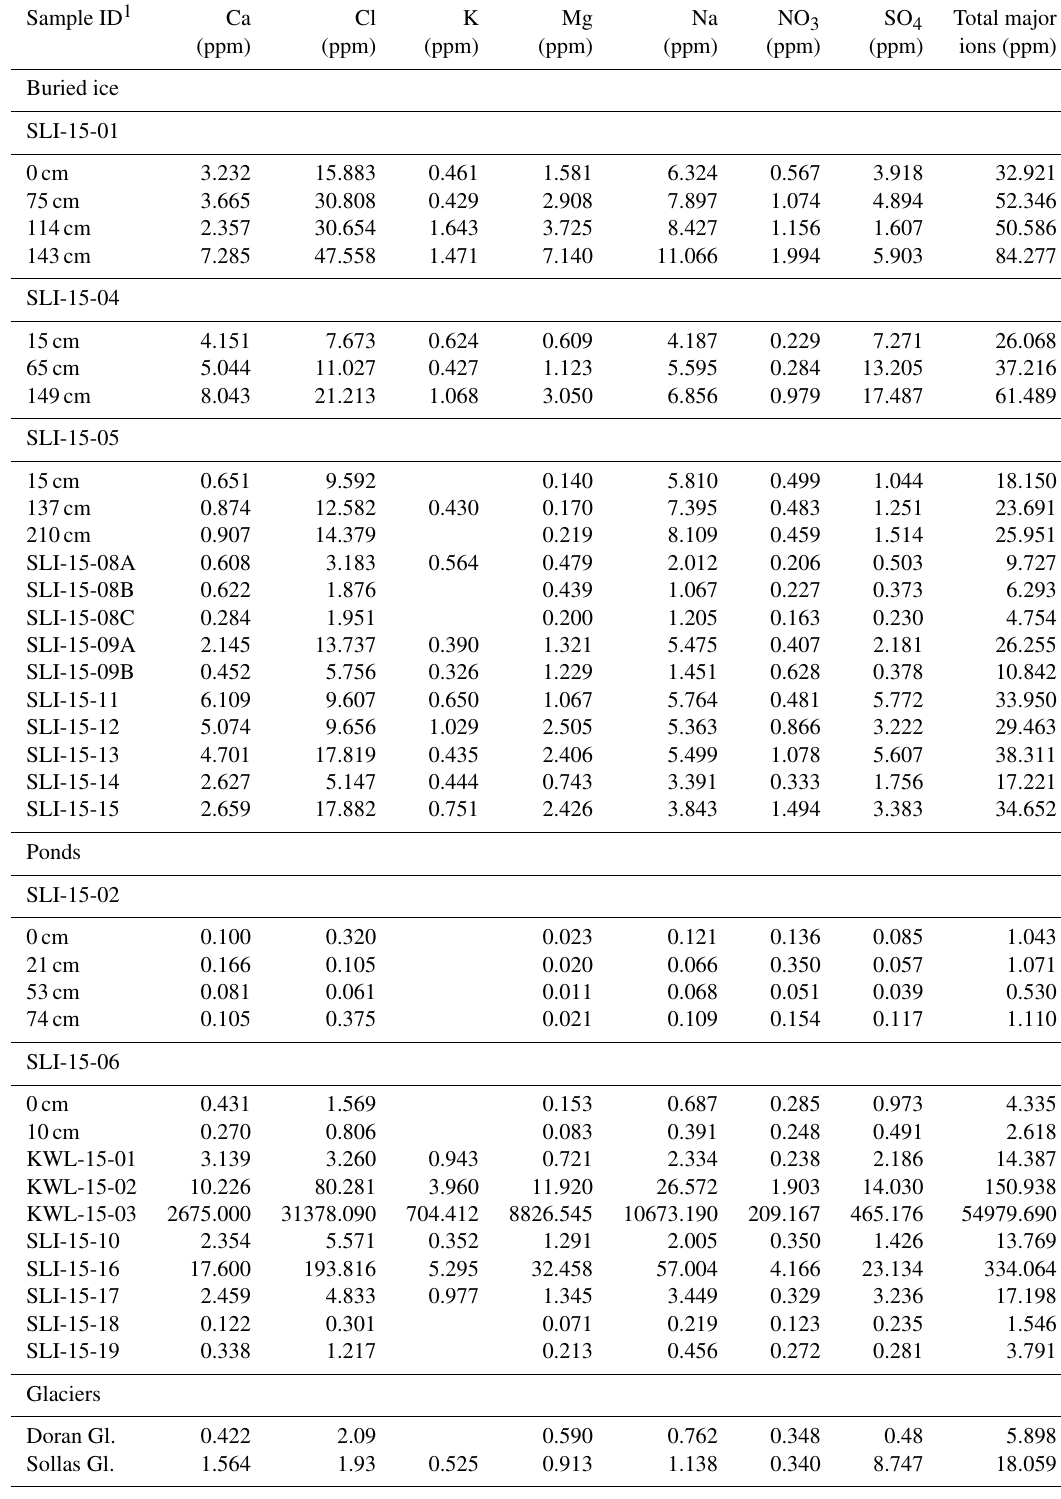
Table 3. Major ion